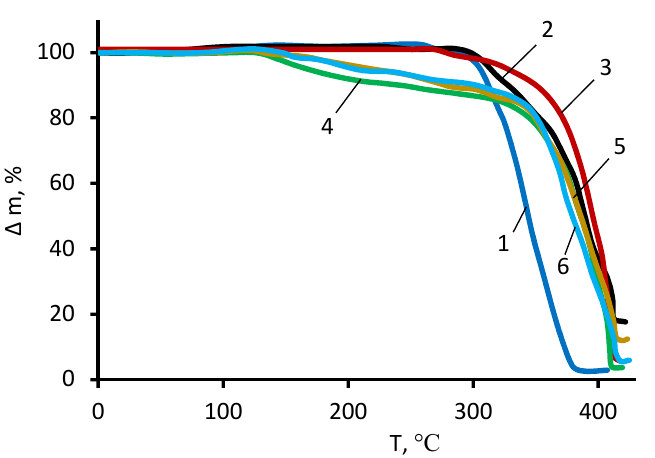
Figure 5. TGA of PEO (1), PEOASiP (2), ASiP–AGM-10 (3), ASiP–AGM-20 (4), ASiP–AGM-30 (5) and ASiP–AGM-50 (6).